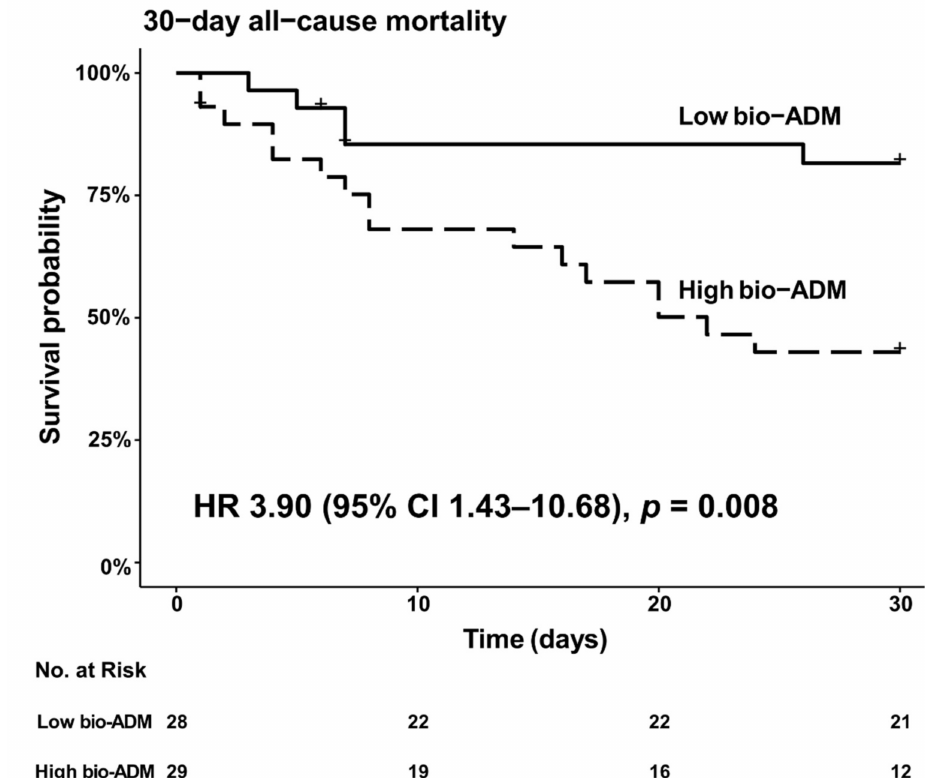
Figure 2. Kaplan–Meier analysis of 30-day all-cause mortality in cardiogenic shock patients with high bio-ADM value at inclusion ( ≥ 53.8 pg/mL) vs. low bio-ADM (<53.8 pg/mL). Dichotomization of patients was based on bio-ADM value 53.8 mg/mL, which was the median value of bio-ADM at inclusion (interquartile range 28.5–85.2 pg/mL). + indicates censoring. bio-ADM, bioactive adrenomedullin; HR, hazard ratio.